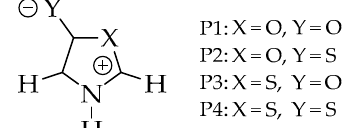
Figure 2. Structures of the investigated systems: Oxazoles ( P1 and P2 ) and thiazoles ( P3 and P4 ).